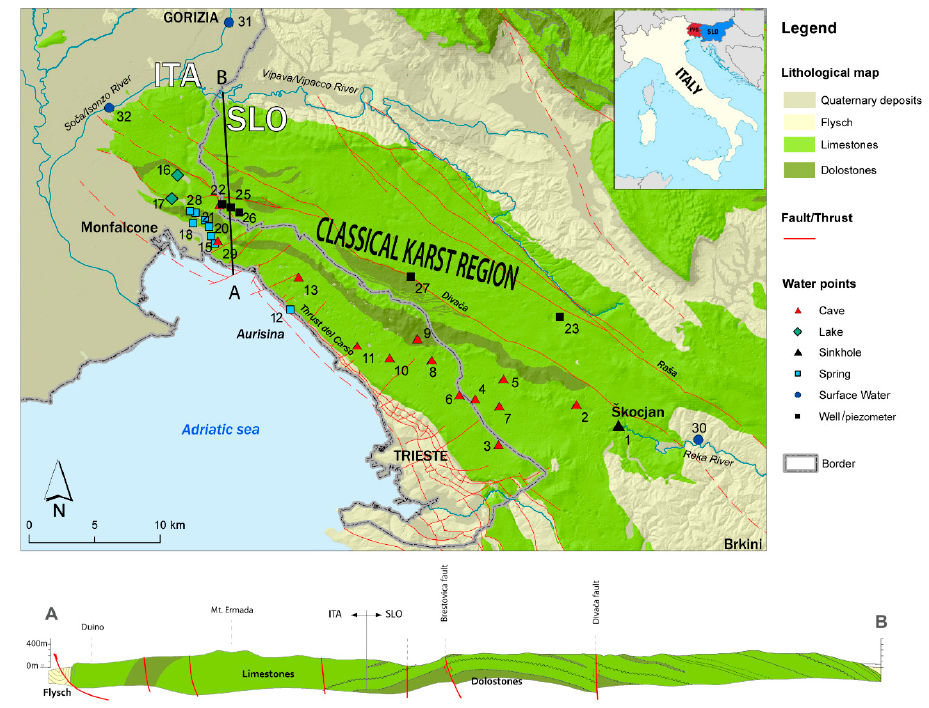
Figure 1. Study area overview, lithological map and simplified cross-section (A–B). The numbers close to the symbols represent the points of the karst hydrostructure where the waters can be identified: